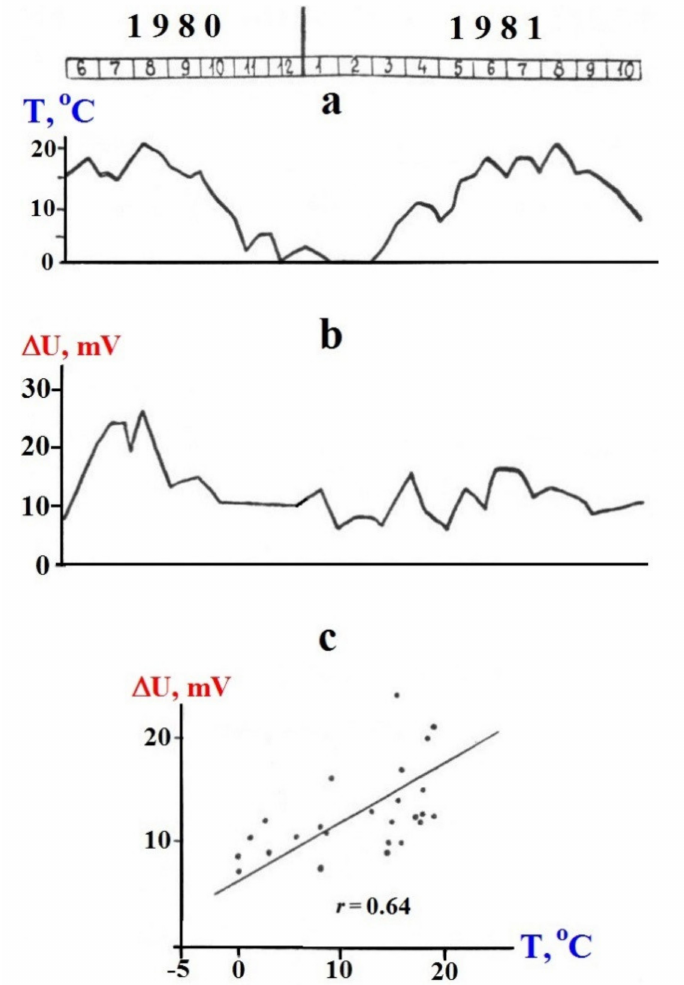
Figure 3. A correlation between temperature and SP observations: ( a ) temperature, ( b ) SP intensity, ( c ) correlation between these parameters ( a , b are taken from [39]). SP observations were carried out in the Middle Keuper of the Steigerwald highlands, 60 km east of Würzburg,